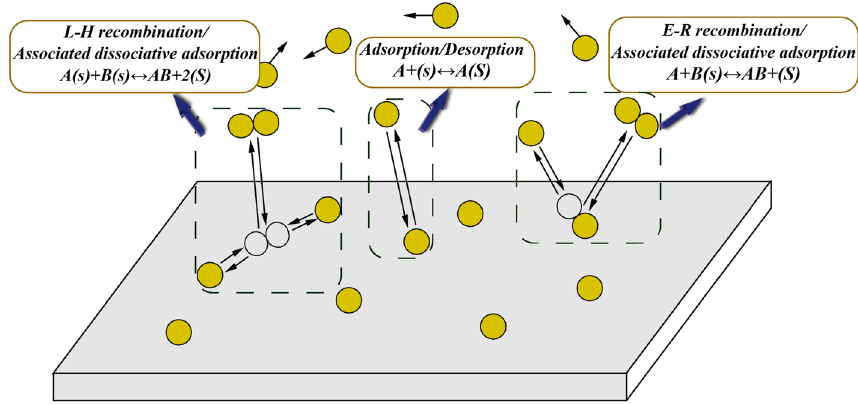
Fig. 18 Mechanisms of catalytic recombination reaction on the